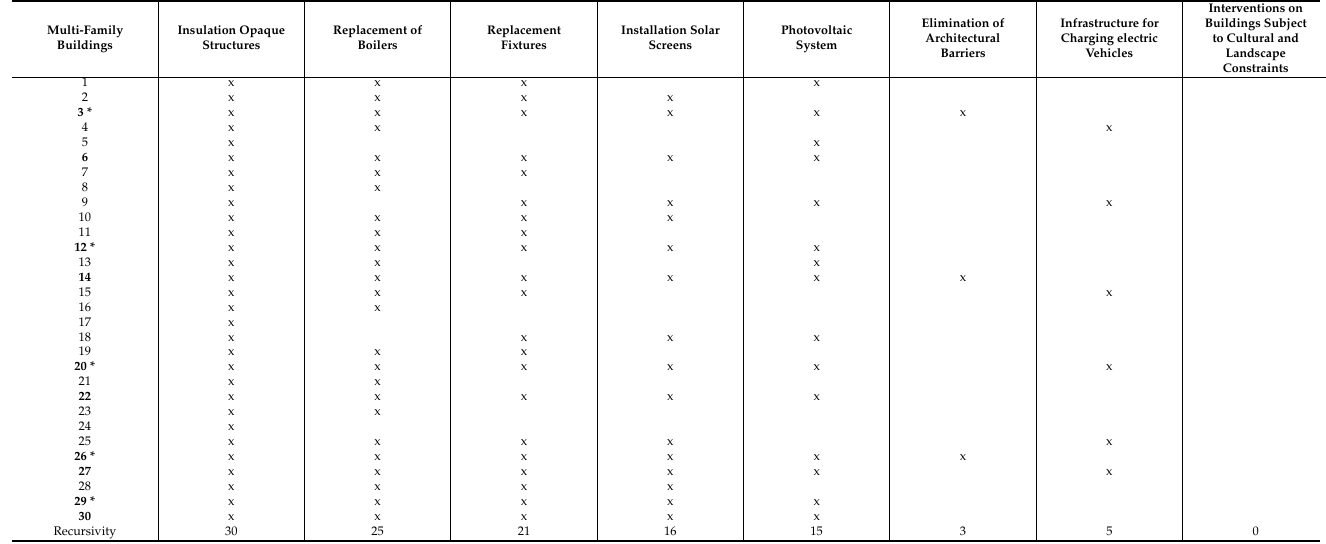
Table A2. Identification of the most recurrent works carried out on the properties under